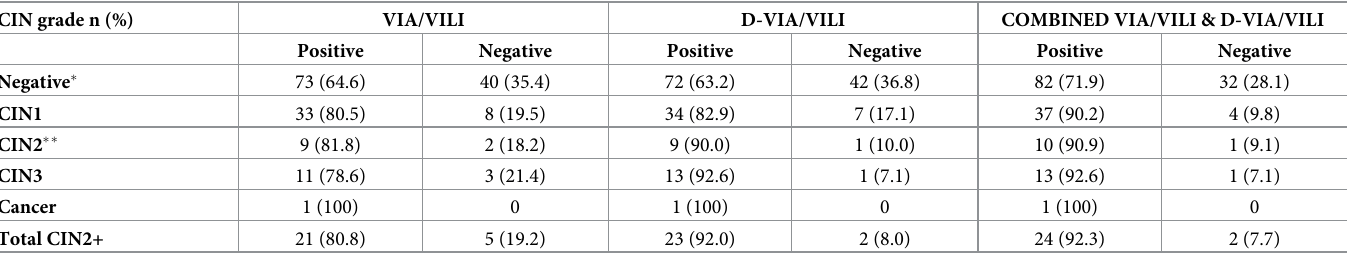
Table 2. VIA/VILI, D-VIA/VILI and combined assessment of histopathologic results, categorized by CIN